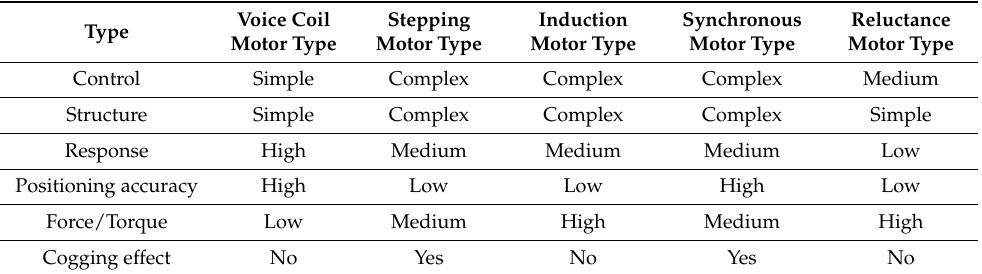
Table 1. Performance comparison list of several kinds of 3-DOF